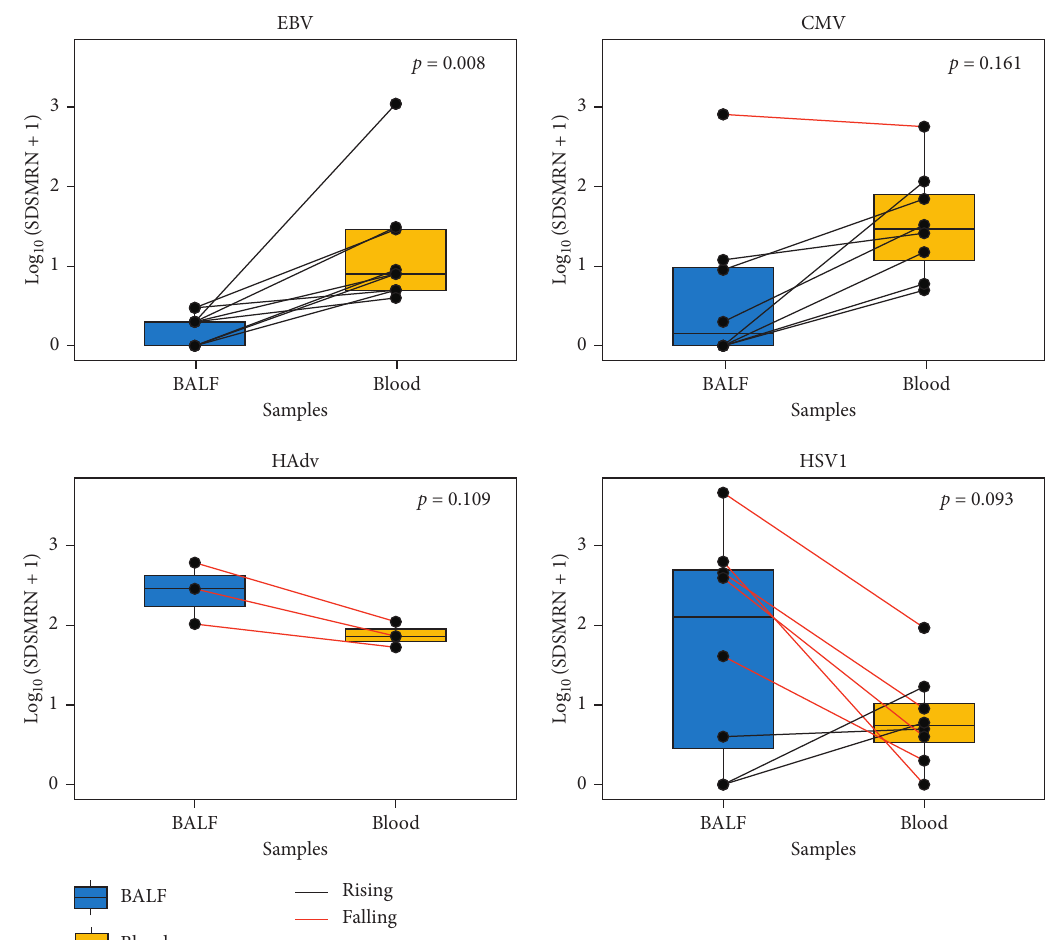
Figure 3: Comparison of the number of reads in BALF and blood mNGS for different viruses. The Log by BALF and blood mNGS were shown in blue and yellow. The paired data were connected by a straight line: red suggested a higher result in BALF and black suggested higher in blood. Abbreviations: mNGS, metagenomic next-generation sequencing; BALF, bronchoalveolar lavage fluid; EBV, Epstein-Barr virus; CMV, Cytomegalovirus ; HAdv, human adenovirus; HSV1, Herpes Simplex Virus type 1; SDSMRN, the number of reads stringently mapped to pathogen